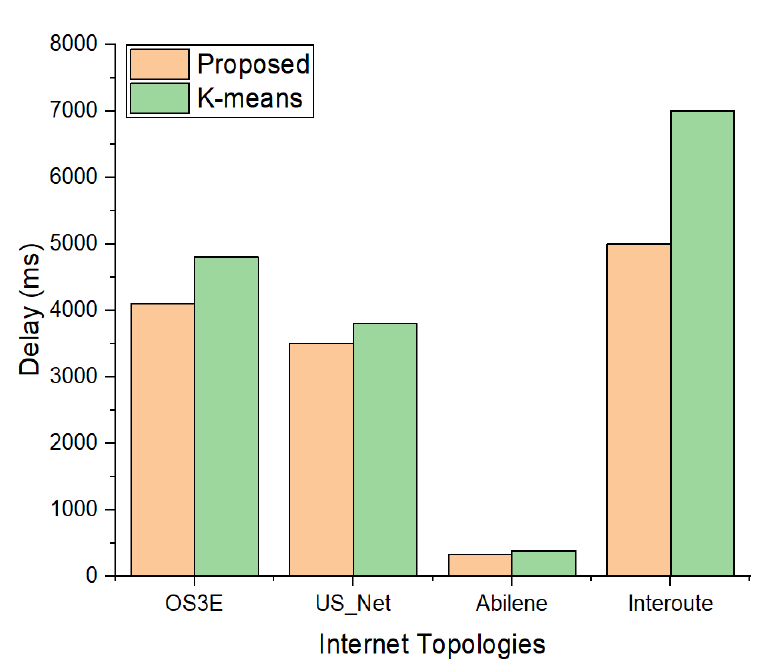
Figure 5. Comparison of E2E delay between proposed scheme and k-means with 6